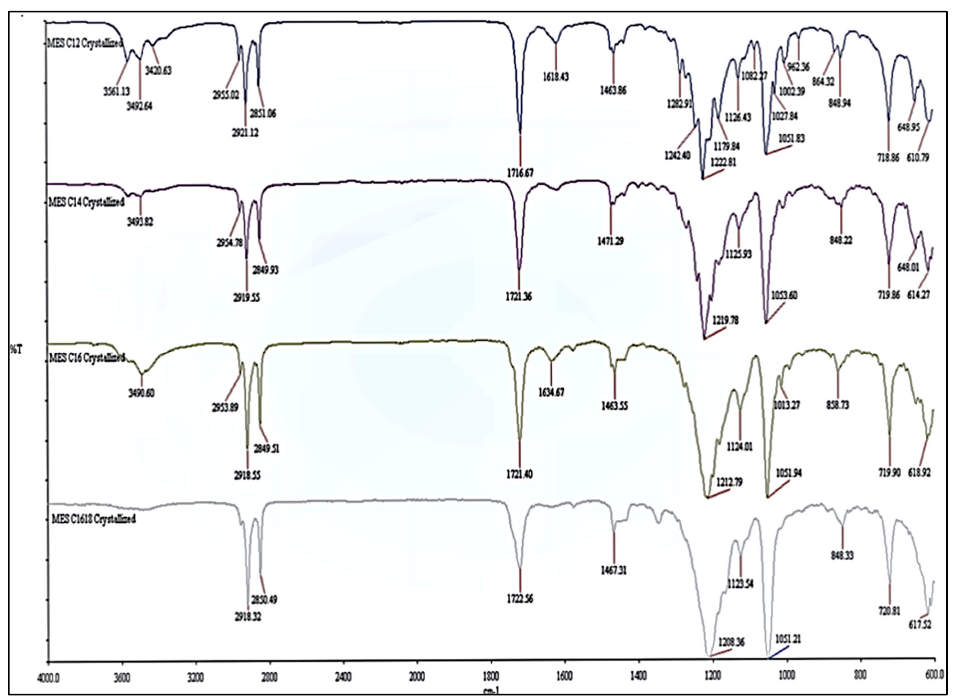
Figure 5. Infrared of MES after repeated crystallization.